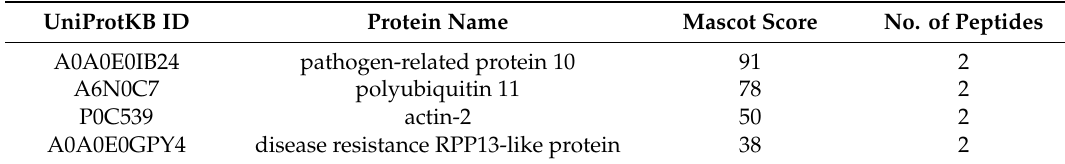
Table 4. Identified Oryza proteins in the GRH honeydew (matched peptides >